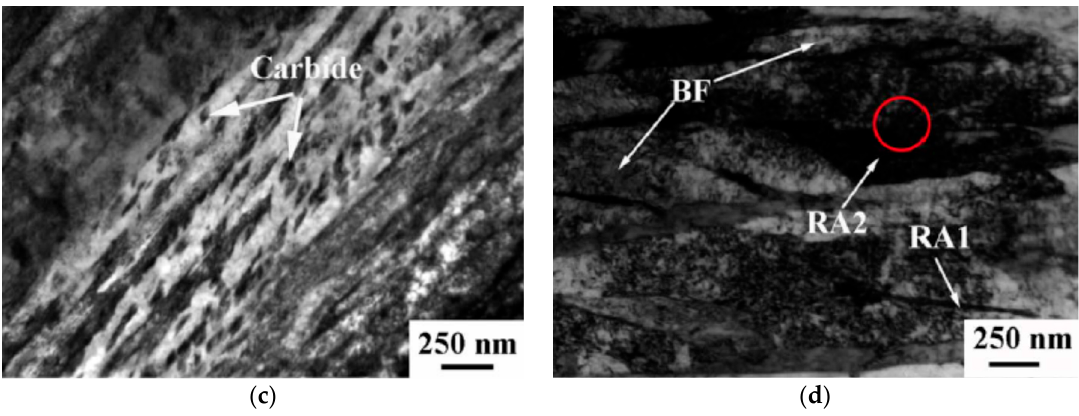
Figure 1. SEM and TEM micrographs [5]: ( a , c ) refer to the carbide-bearing lower bainite; ( b , d ) refer to the carbide-free lower bainite (RA: Retained austenite; BF: Bainitic ferrite). Reprinted from Materials Science & Engineering A, Vol. 715, Xiaoyan Long, Fucheng Zhang, Zhinan Yang, Bo Lv, Study on